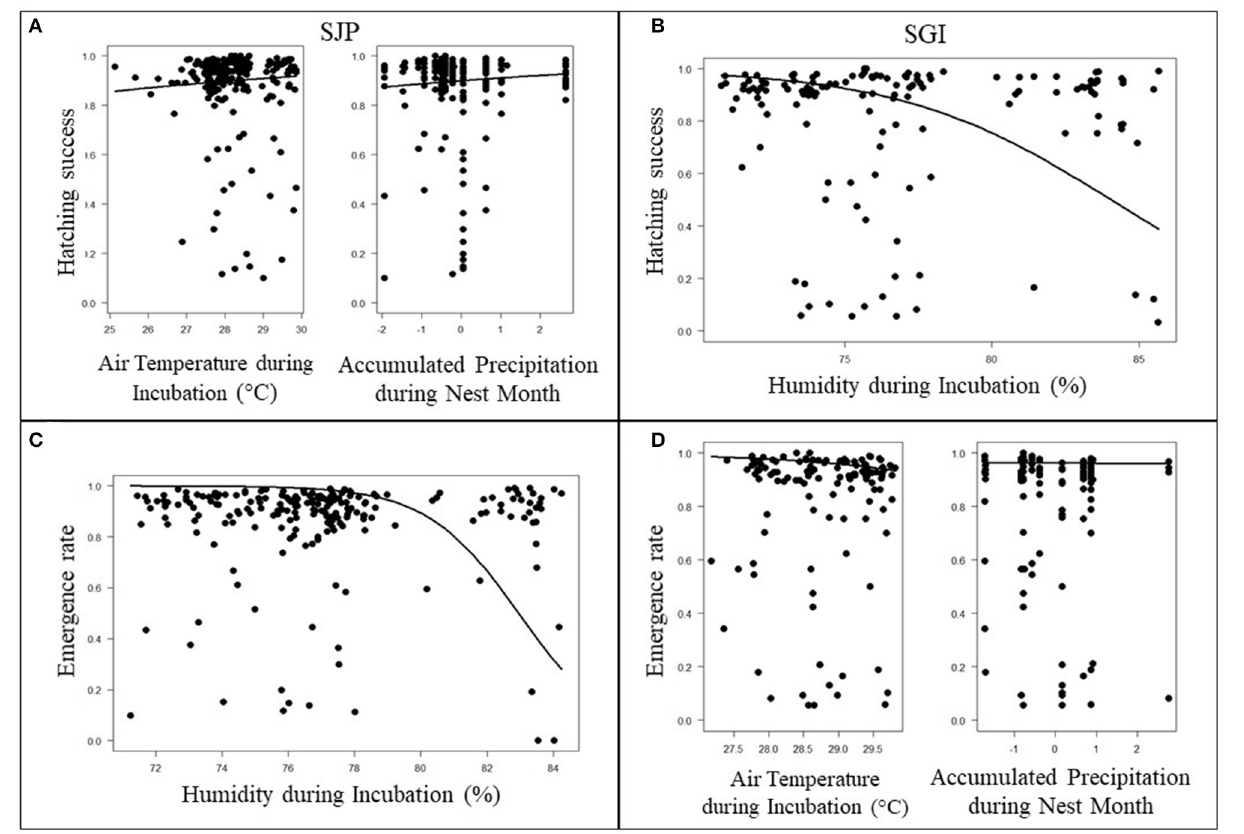
FIGURE 4 | Effects of local climate on hatching success at (A) T.H. Stone Memorial St. Joseph Peninsula (SJP) and (B) St. George Island (SGI) and emergence rate at (C) SJP and (D) SGI are represented by the solid lines. Air temperatures during the incubation period and precipitation during the month the nest was deposited had a positive effect on hatching success at SJP (A) . Humidity during the incubation period had a negative effect with hatching success at SGI (B) and emergence rate at SJP (C) . Air temperatures and precipitation had a negative effect on emergence rate at SGI (D) .